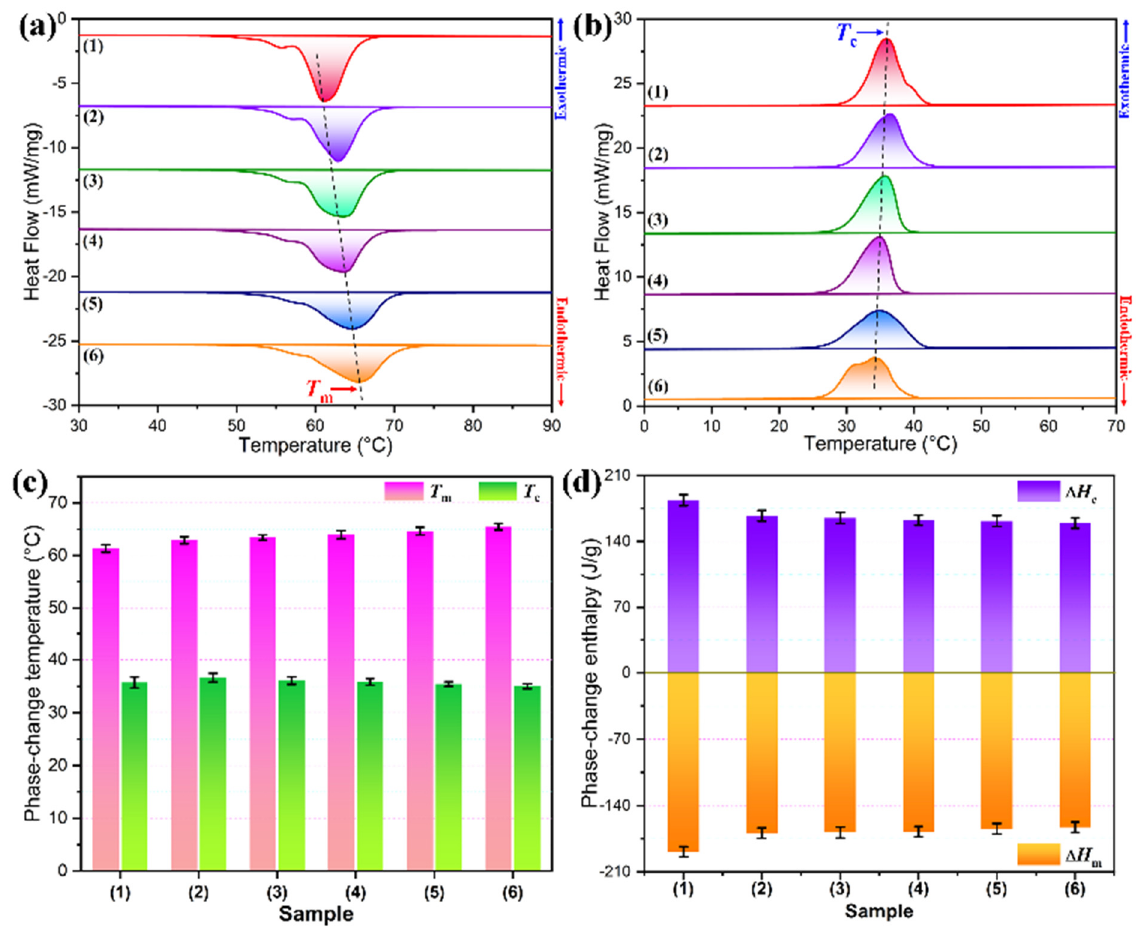
Figure 11. ( a ) DSC cooling thermograms, ( b ) DSC melting thermograms, ( c ) phase-change temperatures, and ( d ) phase- change enthalpies of (1) pure PEG and PI/graphene/Fe 3 O 4 aerogel/PEG composite films with a graphene content of 5 wt% and different Fe 3 O 4 contents of (2) 0, (3) 2, (4) 4, (5) 6, and (6) 8 wt%.